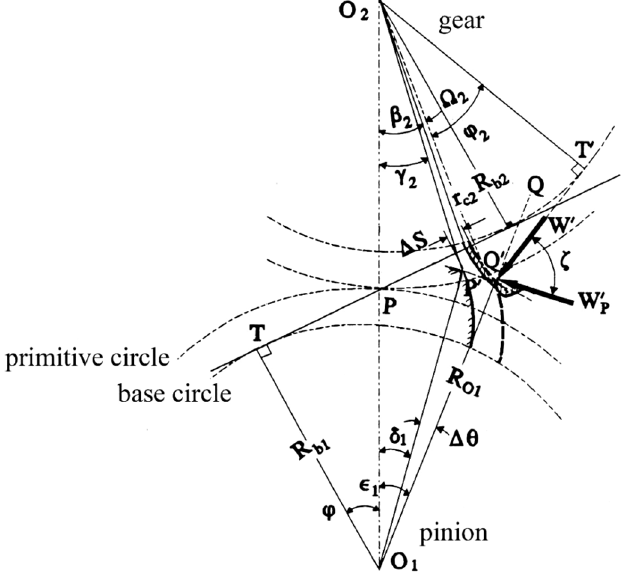
Fig. A.3. Case where the head of the pinion tooth enters in contact prematurely with the root of the gear